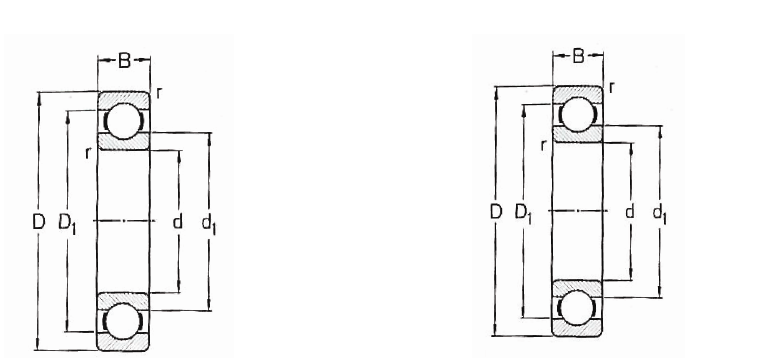
Figure 13 – Ball bearings of the generator of increased radial clearance C 3 and C 4 Рисунок 13 – Изображение шариковых подшипников для генераторов с увеличенными радиальными зазорами C 3 и C 4 Слика 13 – Приказ кугличних лежајева генератора повећане радијалне зрачности C 3 и C 4